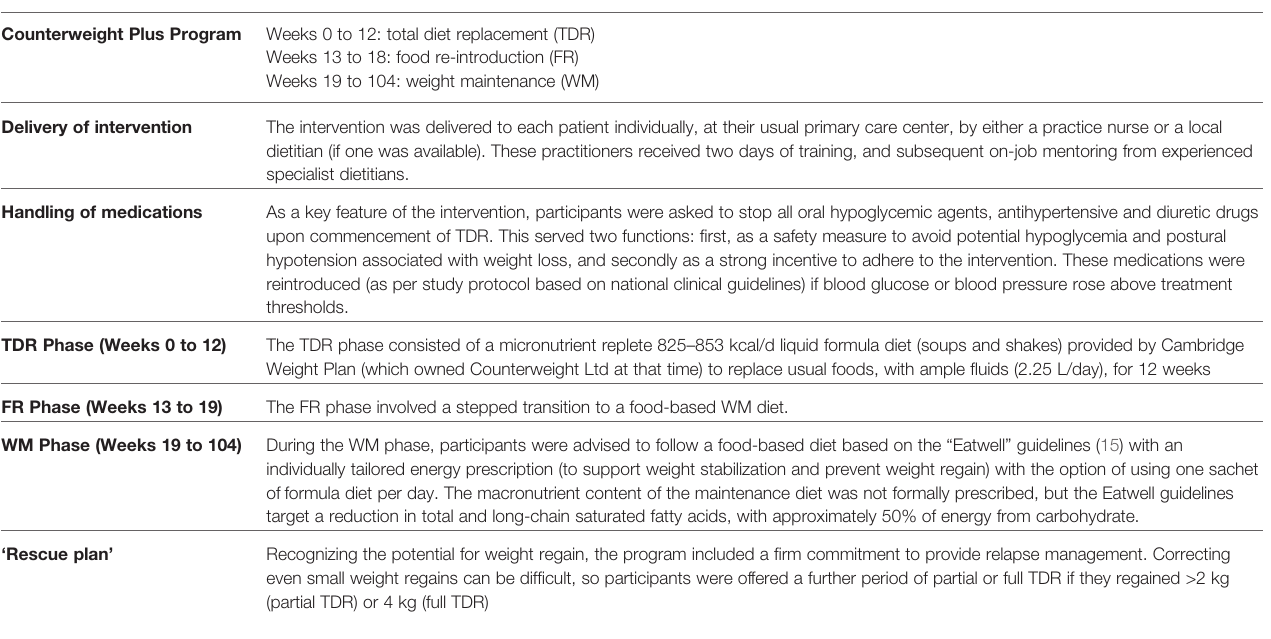
TABLE 2 | Intervention characteristics in DiRECT.